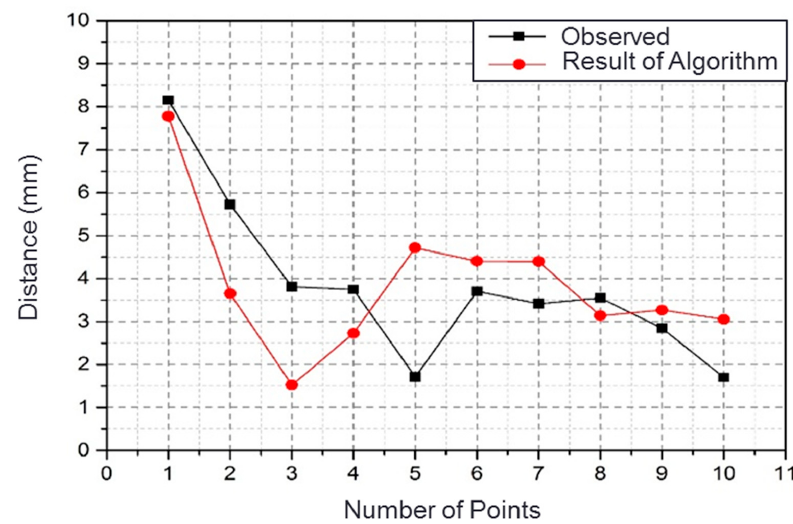
Figure 15. Distance from the center of the crucible in the growth furnace to the island center point.